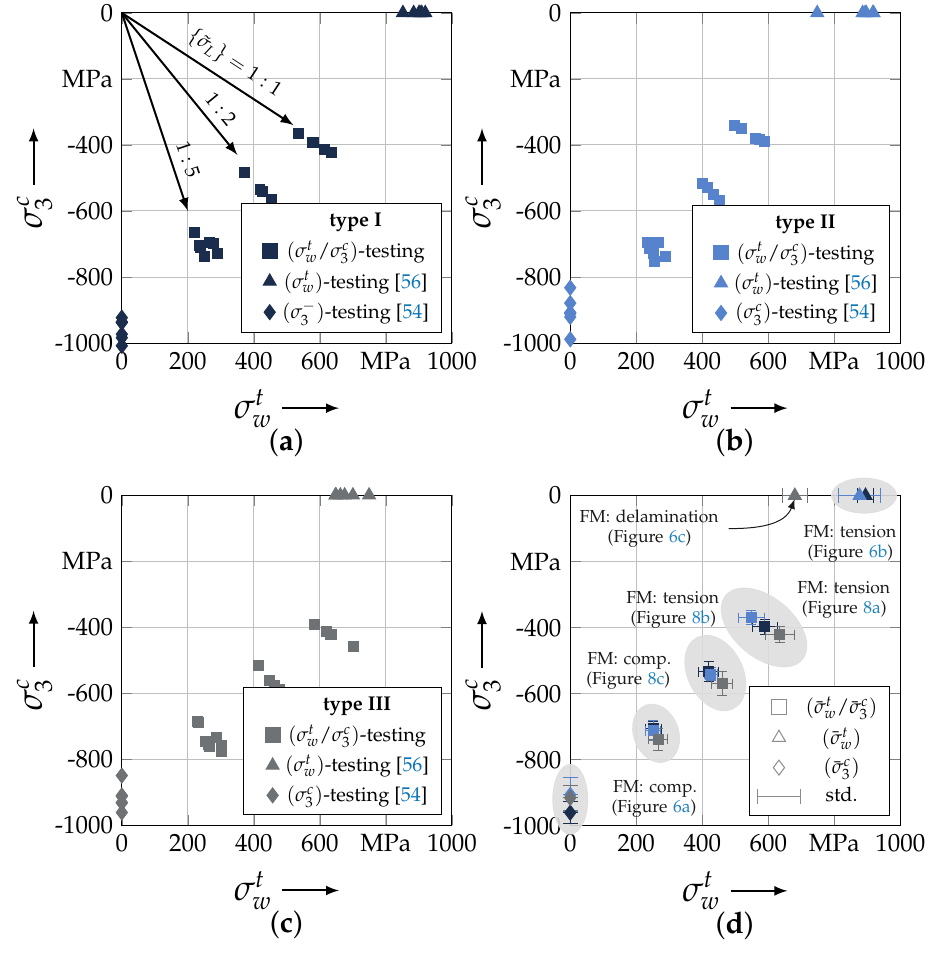
Figure 7. Experimental results: ( a ) type I, ( b ) type II, ( c ) type III (according to Table 1) and ( d ) comparison of mean values and classification of failure